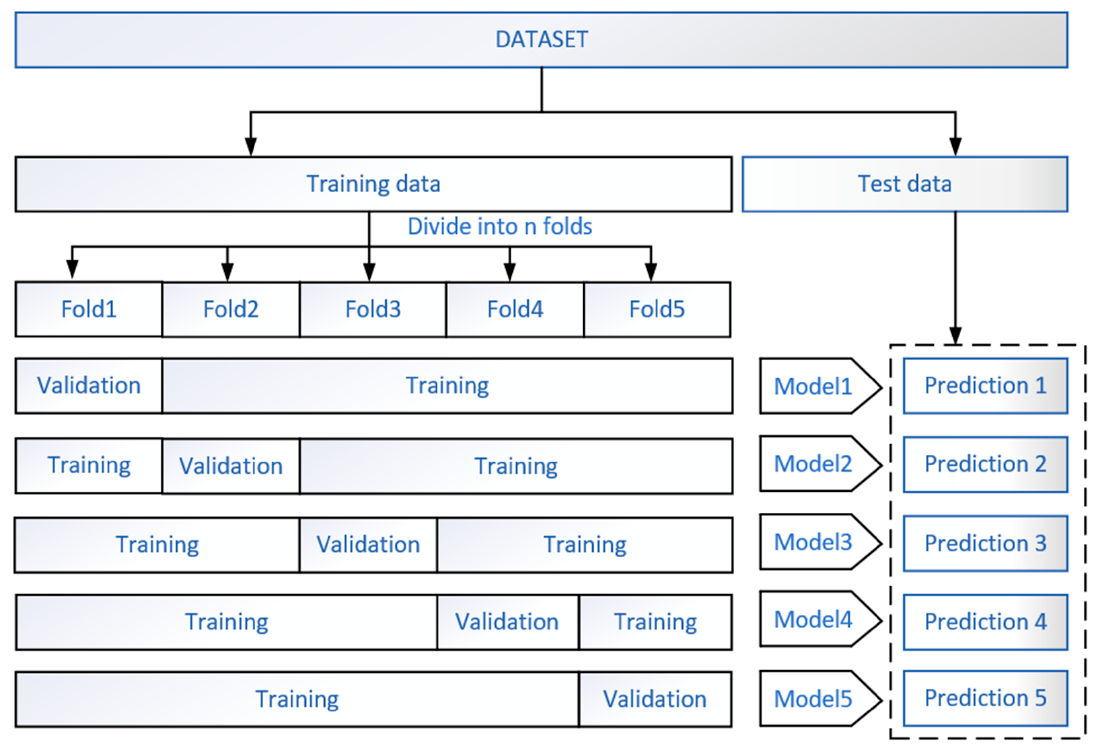
Figure 9. Five-fold cross-validation, leaving one for validation and the remaining four for training.